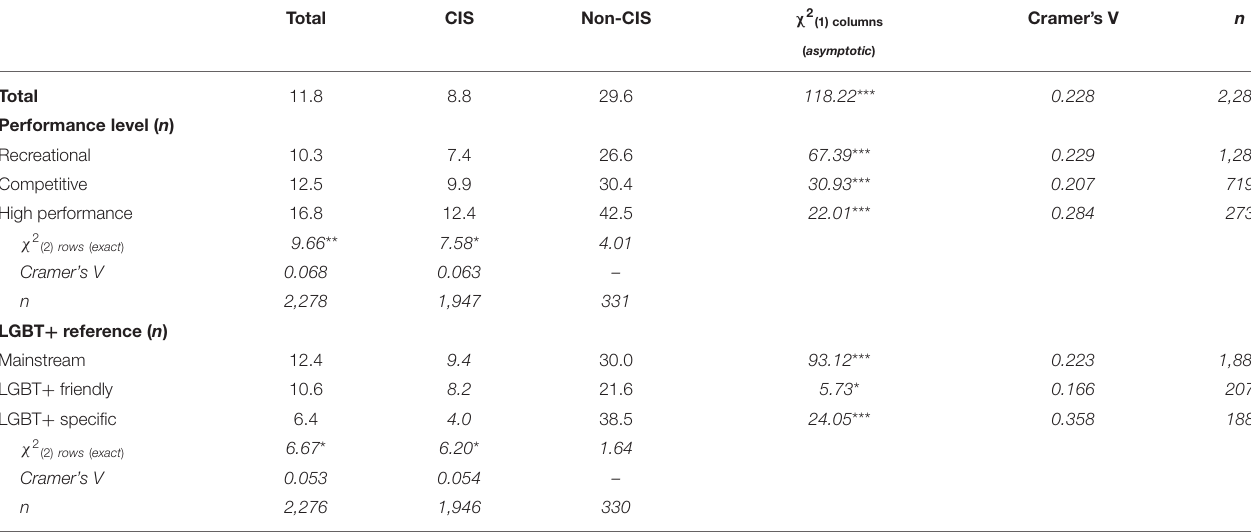
TABLE 2 | Personal negative experiences due to SOGI in different settings by gender identity